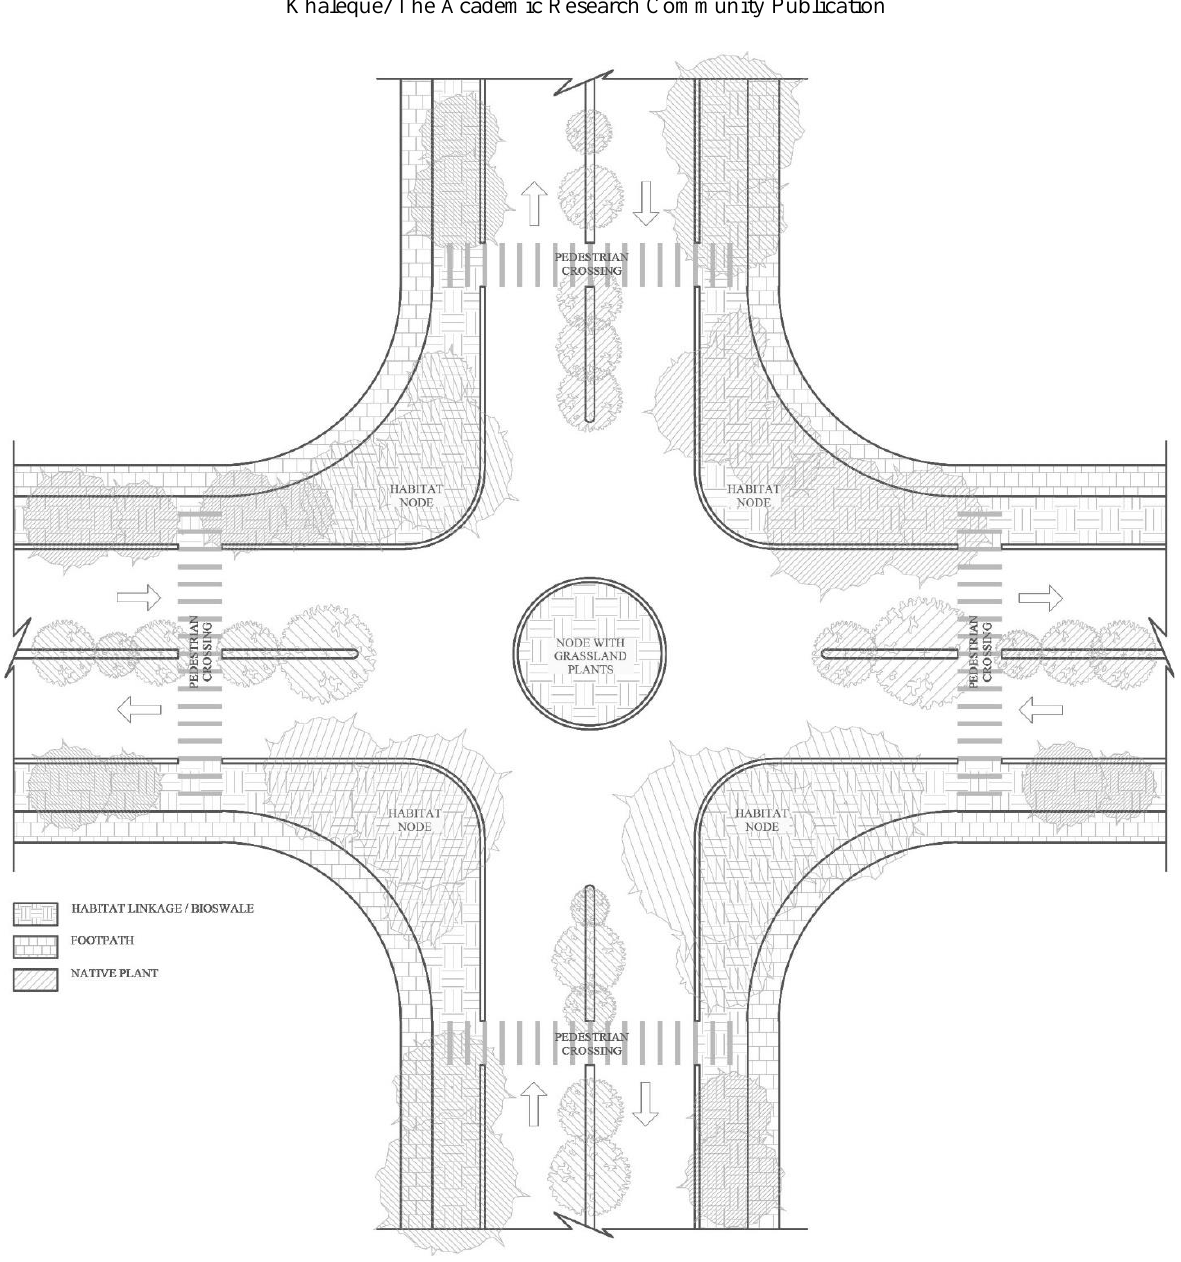
e.g., Operculina turpethum (Turpeth), Tamarindus indica (Tamarind), Crataeva magna (Three leaved caper),